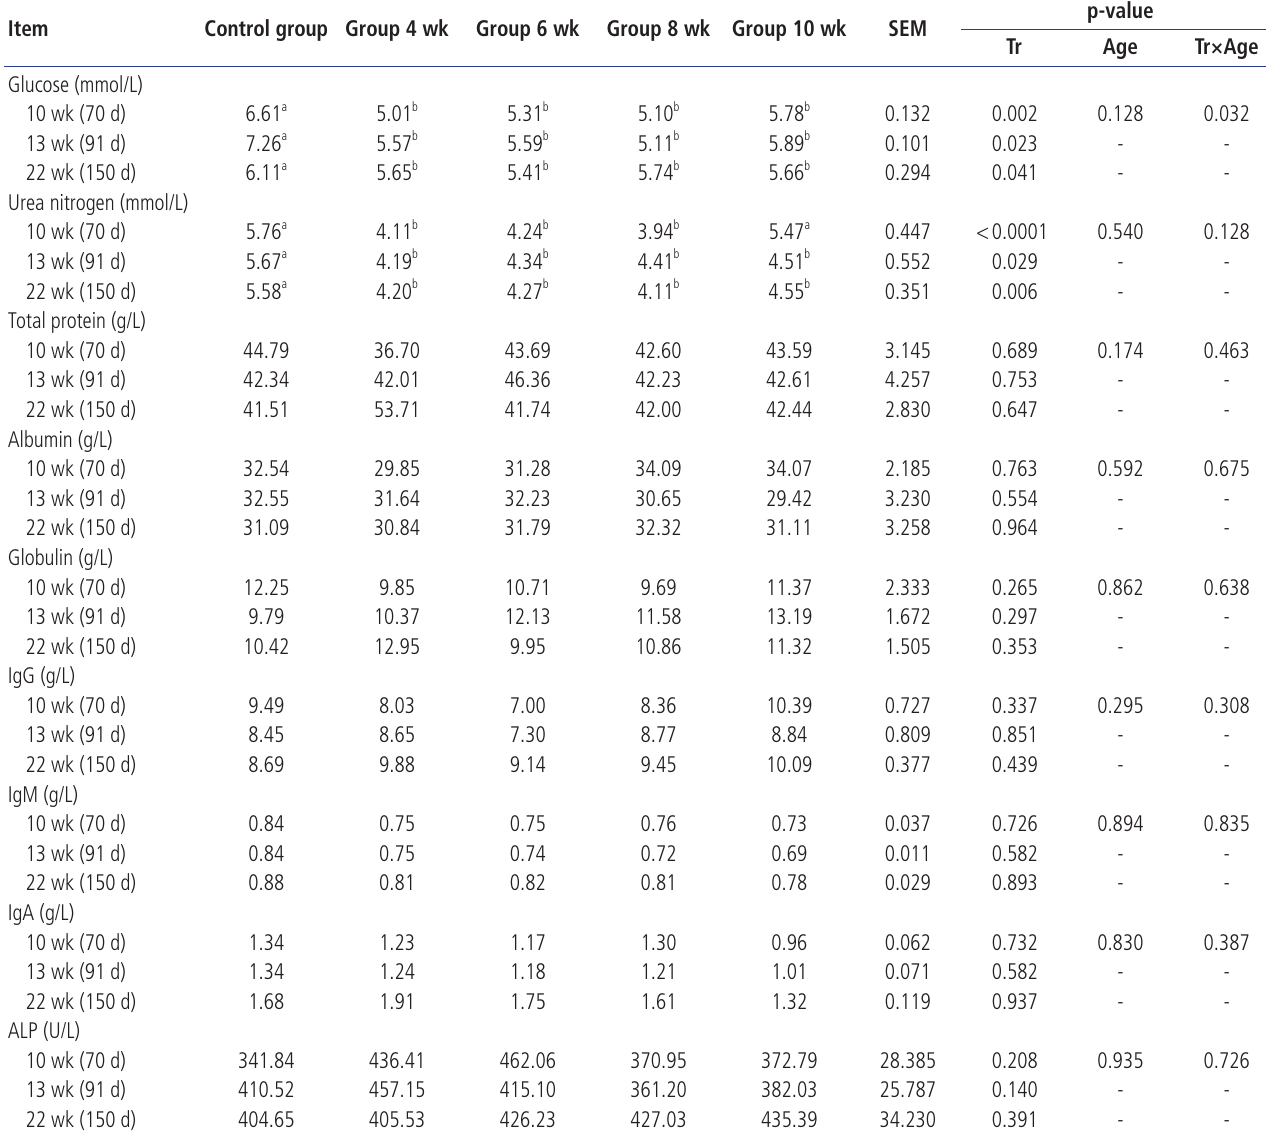
Table 4. Effect of weaning age on blood-biochemical parameters and immune biomarkers of calves Item Control group Group 4